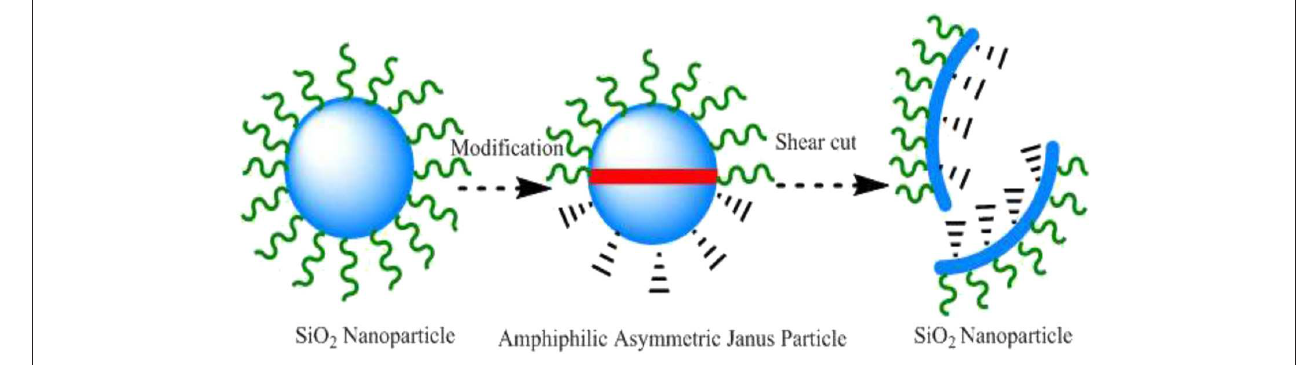
FIGURE 1 | Preparation of amphiphilic asymmetric Janus nanosheets.